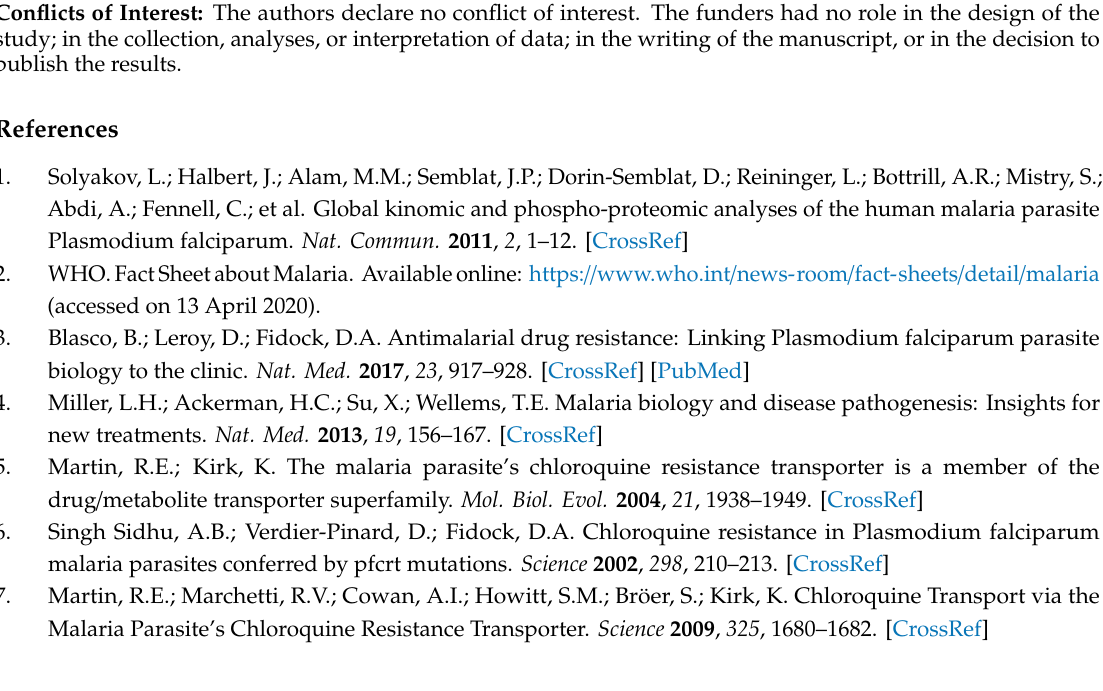
Figure S1: Growth curve of P. falciparum in the presence of compounds ( 1 – 31 ) in di ff erent concentrations (0.0488–50 µ M). Table S1: Compounds ( 1 – 54 ) that have demonstrated antimalarial activity 1 – 31 and compounds without the ability to inhibit the development of P. falciparum parasitemia by 50% at the tested concentrations (0.0488–50 µ M) 32 – 54